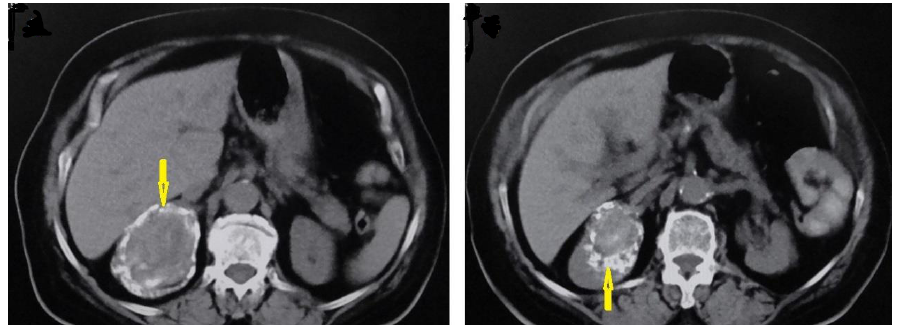
Figure 12. Selected axial images of abdominal CT of a 60-year-old female showing a well-circumscribed unilocular cystic lesion in the right kidney with calcified margins (arrows), no mass effect, and no daughter cysts inside it, which is typical of hydatid cyst Type III.